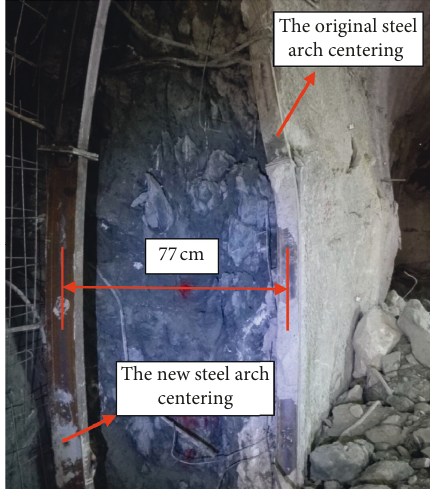
Figure 2: The large distortion section.